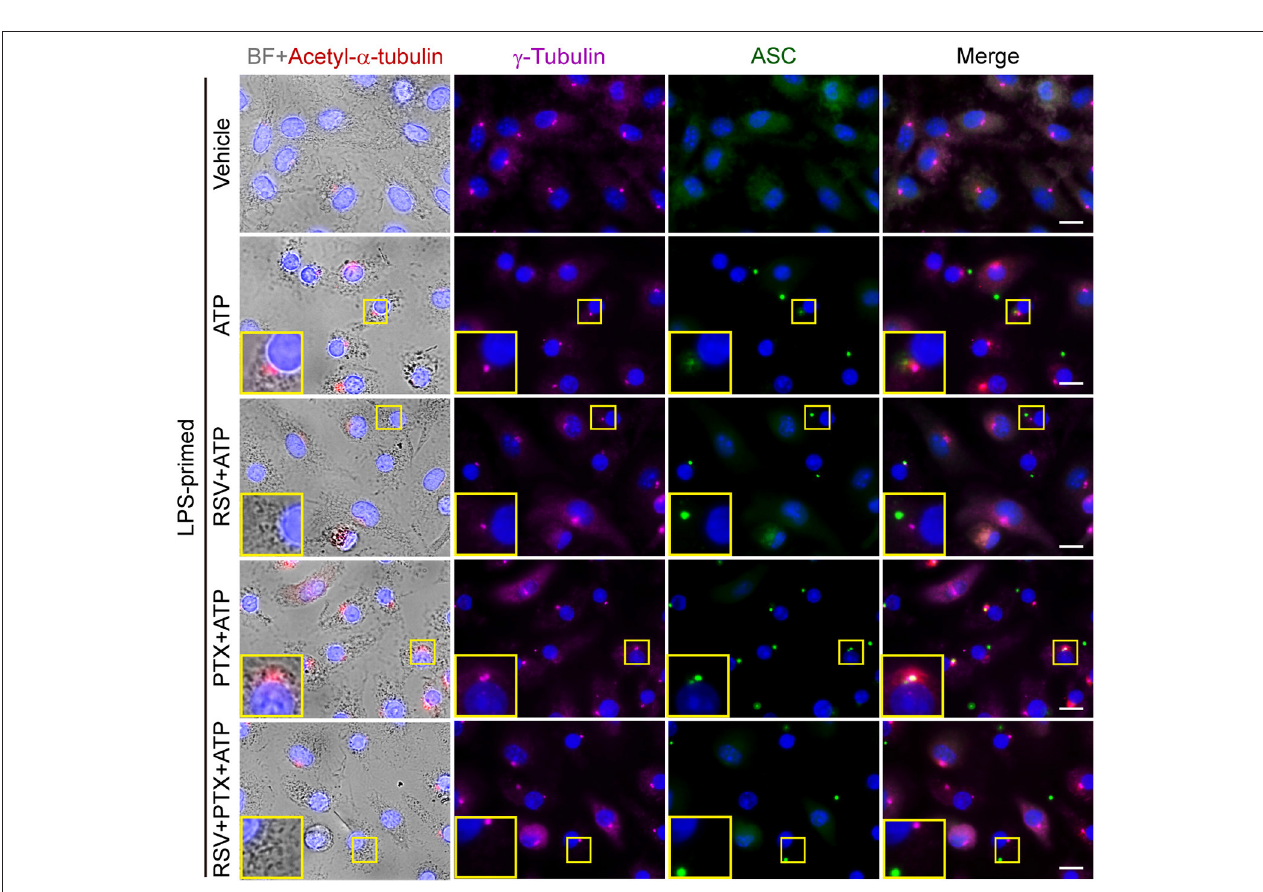
FIGURE 4 | immunofluorescent microscopy. (C) Representative images showing ASC (green) subcellular distribution. Nuclei (blue) were revealed by Hoechst 33342. Yellow arrows indicate ASC specks and the enlarged inset showing cells with an ASC speck. Scale bars, 20 µ m. (D) Percentages of cells with an ASC speck relative to total cells from 5 random fields each containing ∼ 200 cells (see Figure S7 ). Data were analyzed using the non-parametric Mann–Whitney U -test, which are shown as mean ± SD ( n = 5). (E) Levels of soluble IL-1 β in culture supernatants were analyzed by cytometric bead array (CBA) assay. Data were analyzed using the one-way ANOVA followed by Turkey post-hoc test, which are shown as mean ± SD ( n = 3) . * P < 0.05; ** P < 0.01; *** P < 0.001; PTX, paclitaxel; RSV, resveratrol.